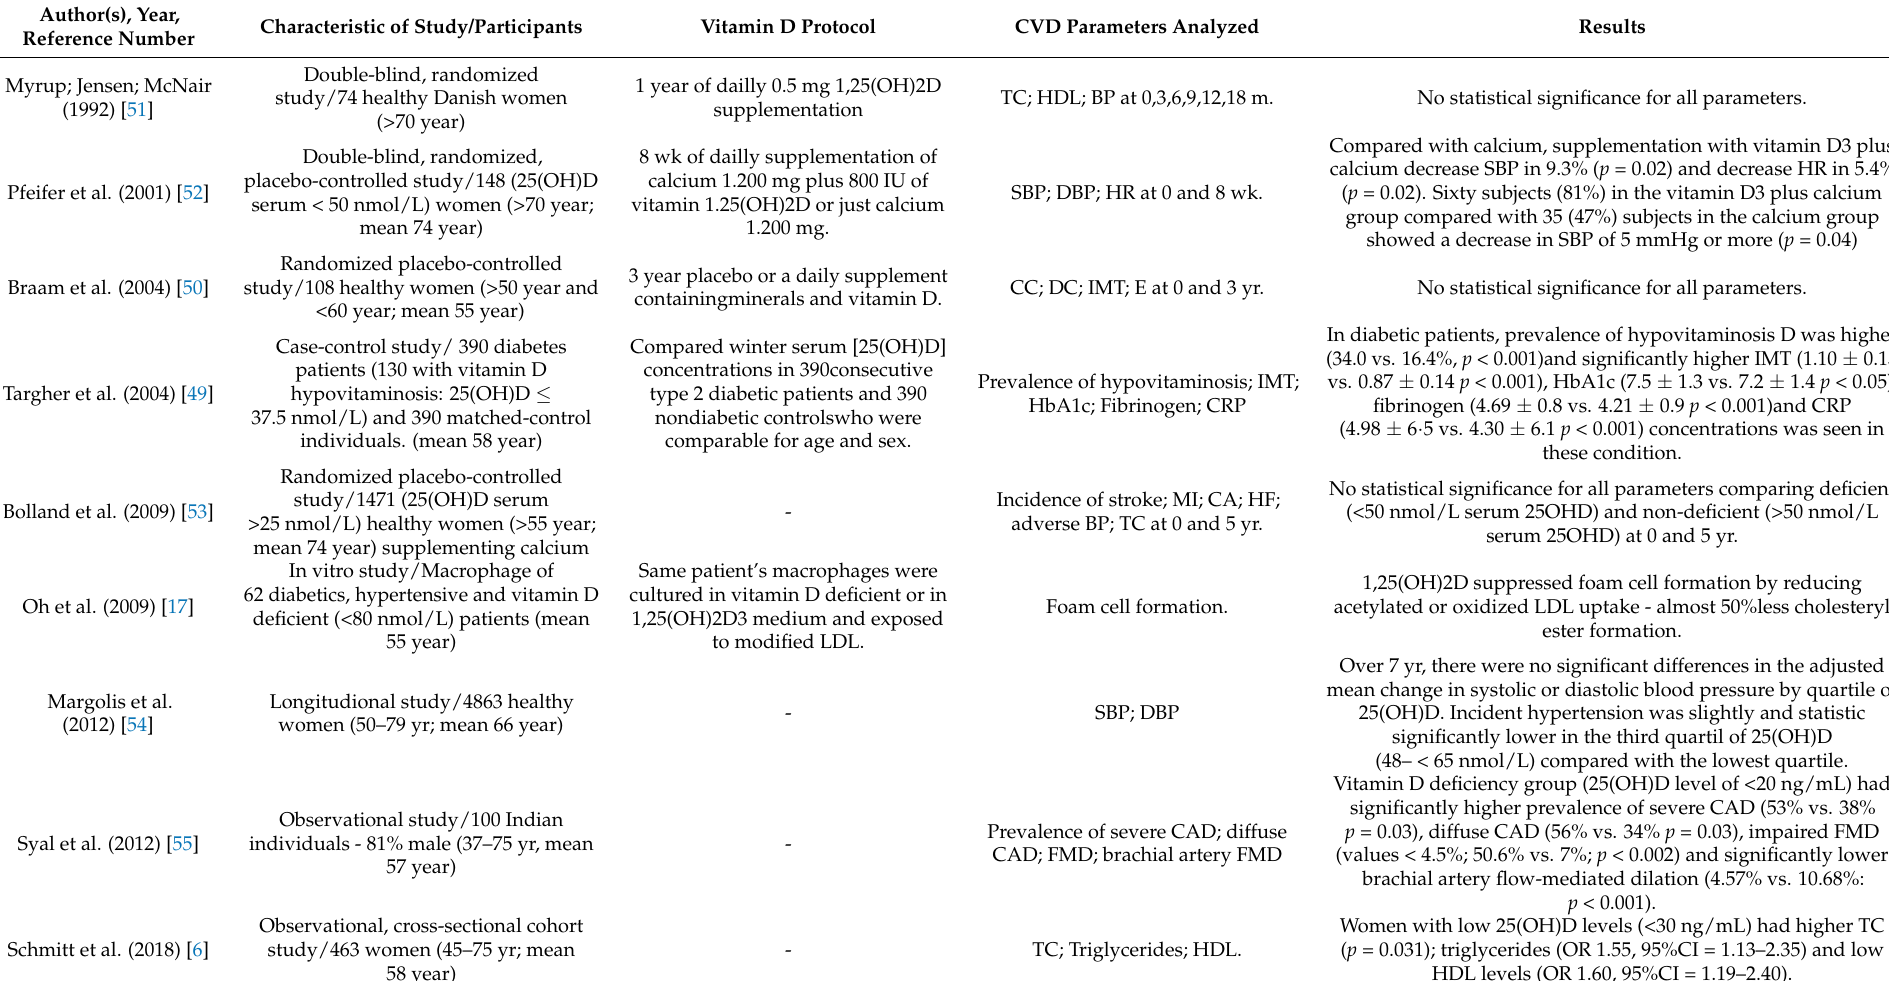
Table 2. Vitamin D and CVD risk